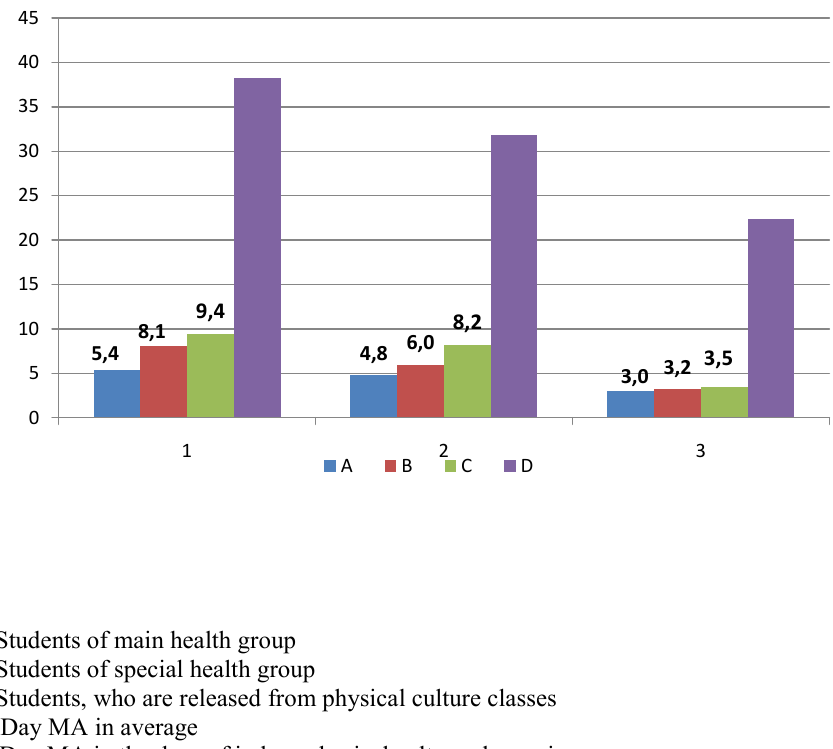
Fig. 3. Motion activity (MA) of students of different health groups.